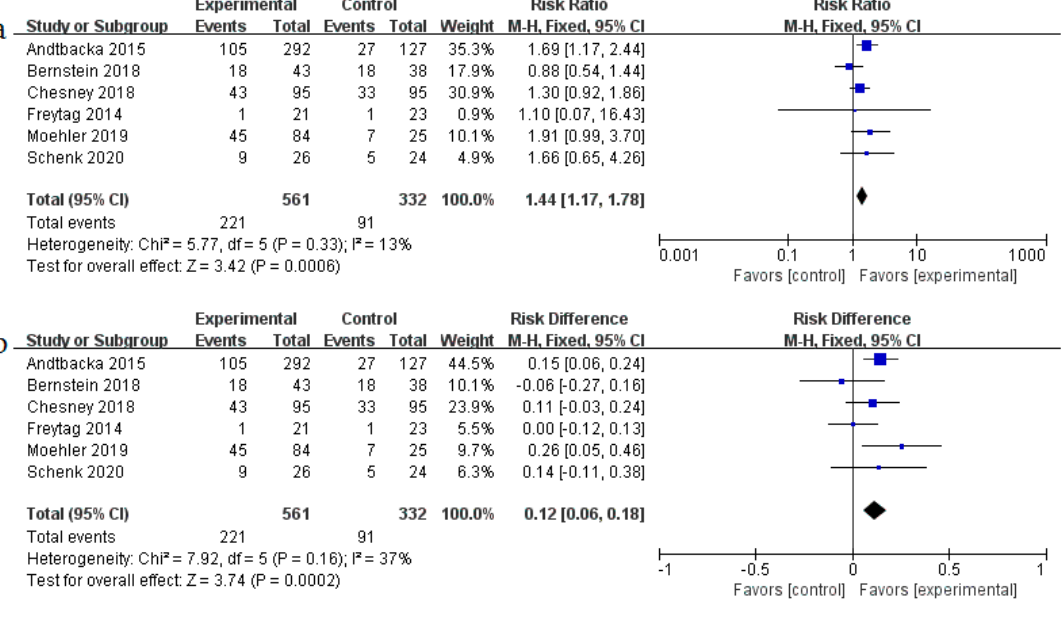
Figure 8. Forest plot of severe adverse events (grade ≥ 3): ( a ) the pooled risk ratios (RR); ( b ) the pooled risk difference (RD). Table 3. Adverse events of interest.